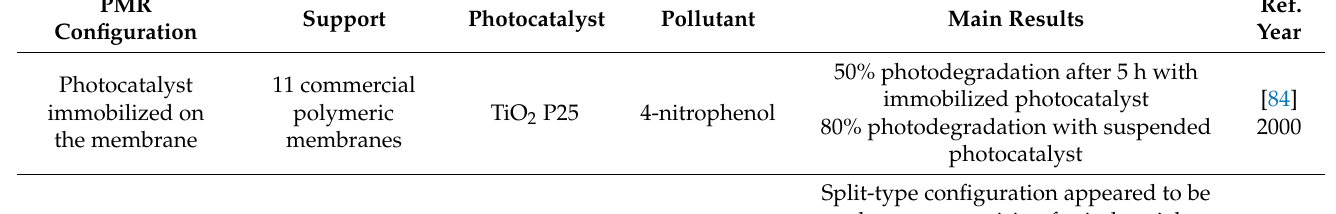
Table 1. Summary of various pressure-driven PMR configurations in water treatment and their main results.